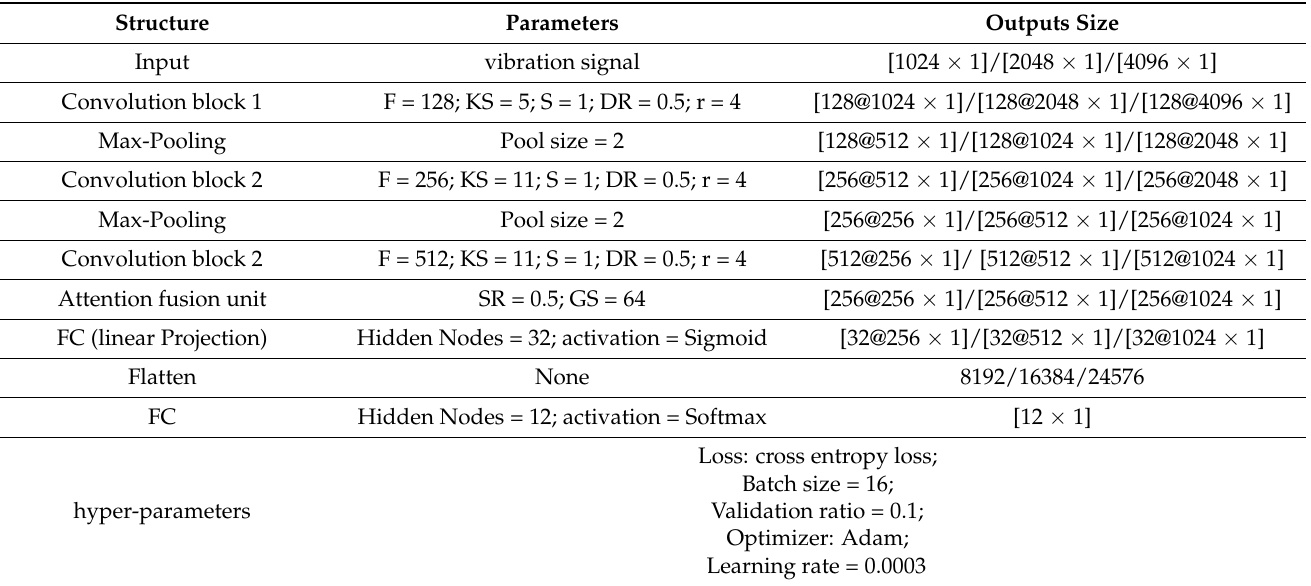
Table 3. Structure parameters and hyper-parameters setup of SRMANet.